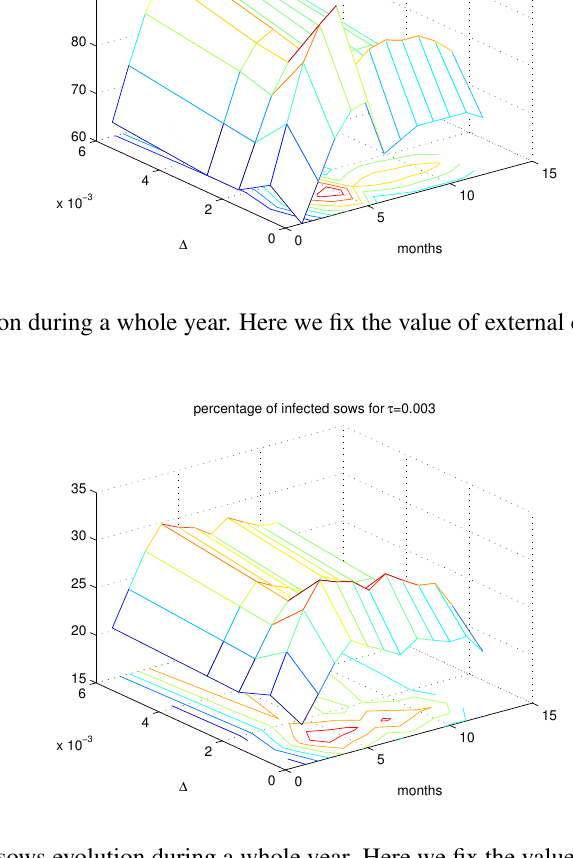
Fig. 6 Percentage of infected sows evolution during a whole year. Here we fix the value of external contamination rate at τ = 0 .